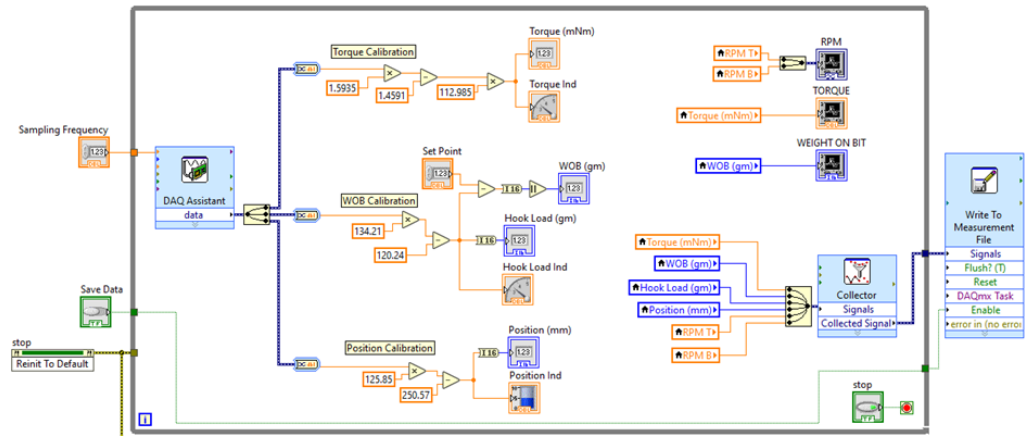
Figure 12. Sensor input and calibration loop.